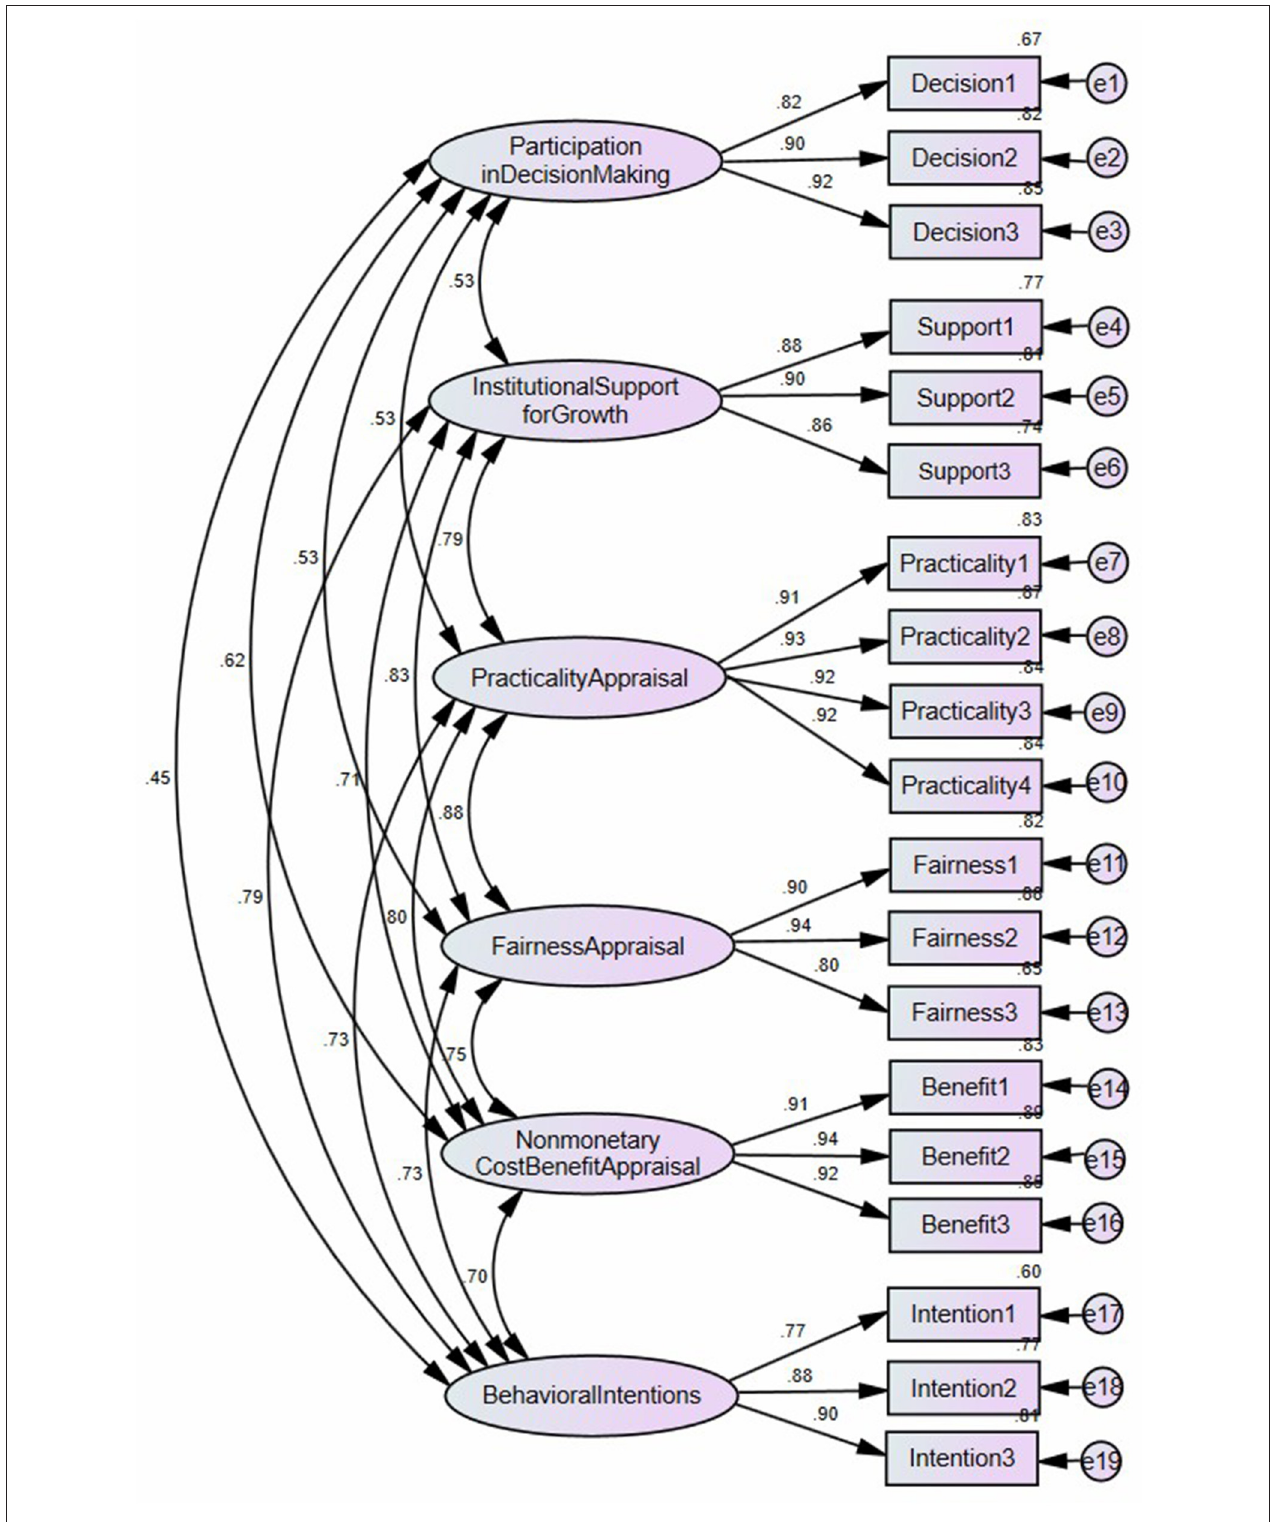
FIGURE 2 | Confirmatory factor analysis ( N =